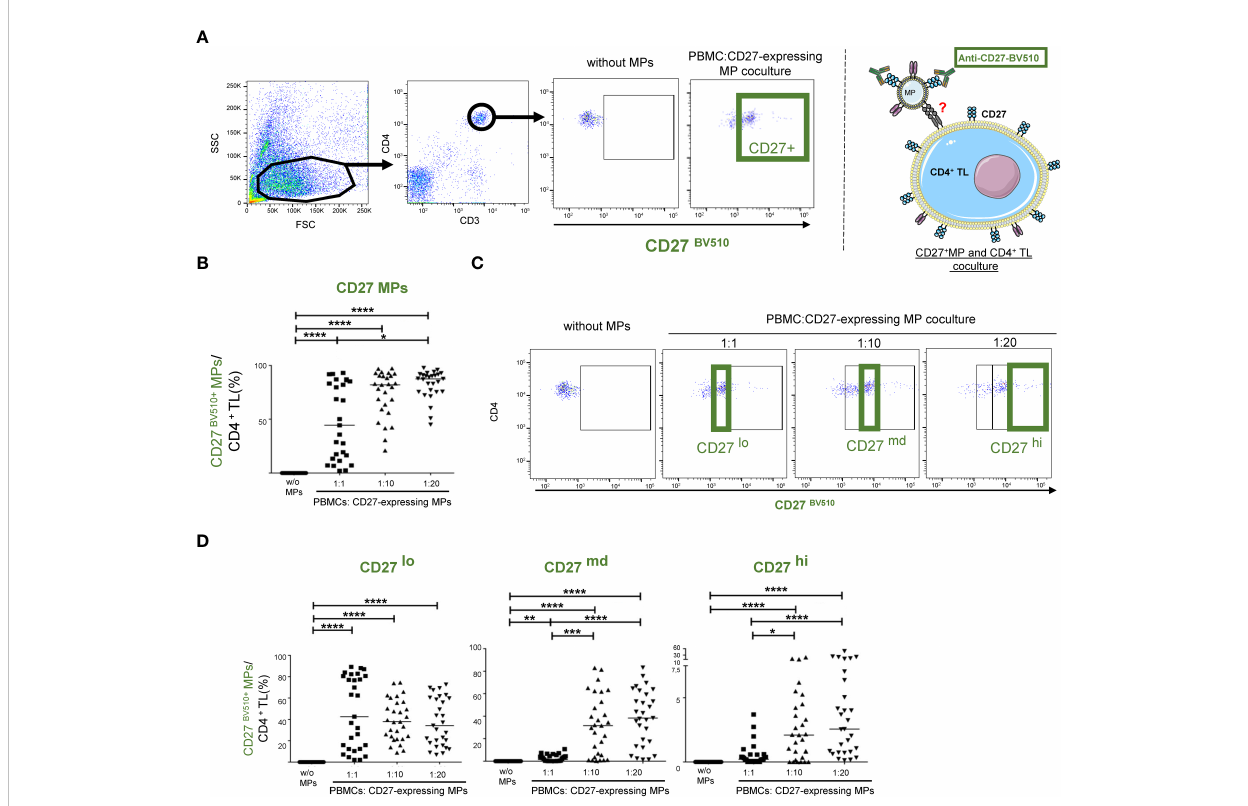
FIGURE 2 CD27 + MP expression on CD4 + TLs after the coculture of MPs and PBMCs. Before culture, MPs were stained with a BV510-labeled anti-CD27 antibody. Samples from 29 HDs were used in 10 coculture experiments. (A) Example of the gating strategy used to assess the interaction of CD27-expressing MPs with CD4 + TLs (PBMCs were stained with anti-CD4 and anti-CD3 antibodies; CD4 + TLs were de fi ned as having a CD3 + CD4 + phenotype), and schematic representation of CD27 + MP binding to CD4 + TLs at 1:1 ratio (PBMCs: CD27-expressing MPs). PBMCs were cocultured for 18 hours with known numbers of CD27-expressing MPs, at ratios of 1:1, 1:10 and 1:20 (PBMCs: CD27-expressing MPs). (B) Percentage of CD4 + TLs expressing CD27 + from MPs at different coculture ratios (PBMCs: CD27-expressing MPs). Horizontal bars indicate the median value. (C, D) Percentage of CD27 + MP expression in the different gates based on the relocation of the MIF. Horizontal bars indicate the median value. P values were obtained in Kruskal-Wallis and Dunn ’ s post hoc tests: **** P < 0.001, *** P < 0.005, ** P < 0.01, * P <